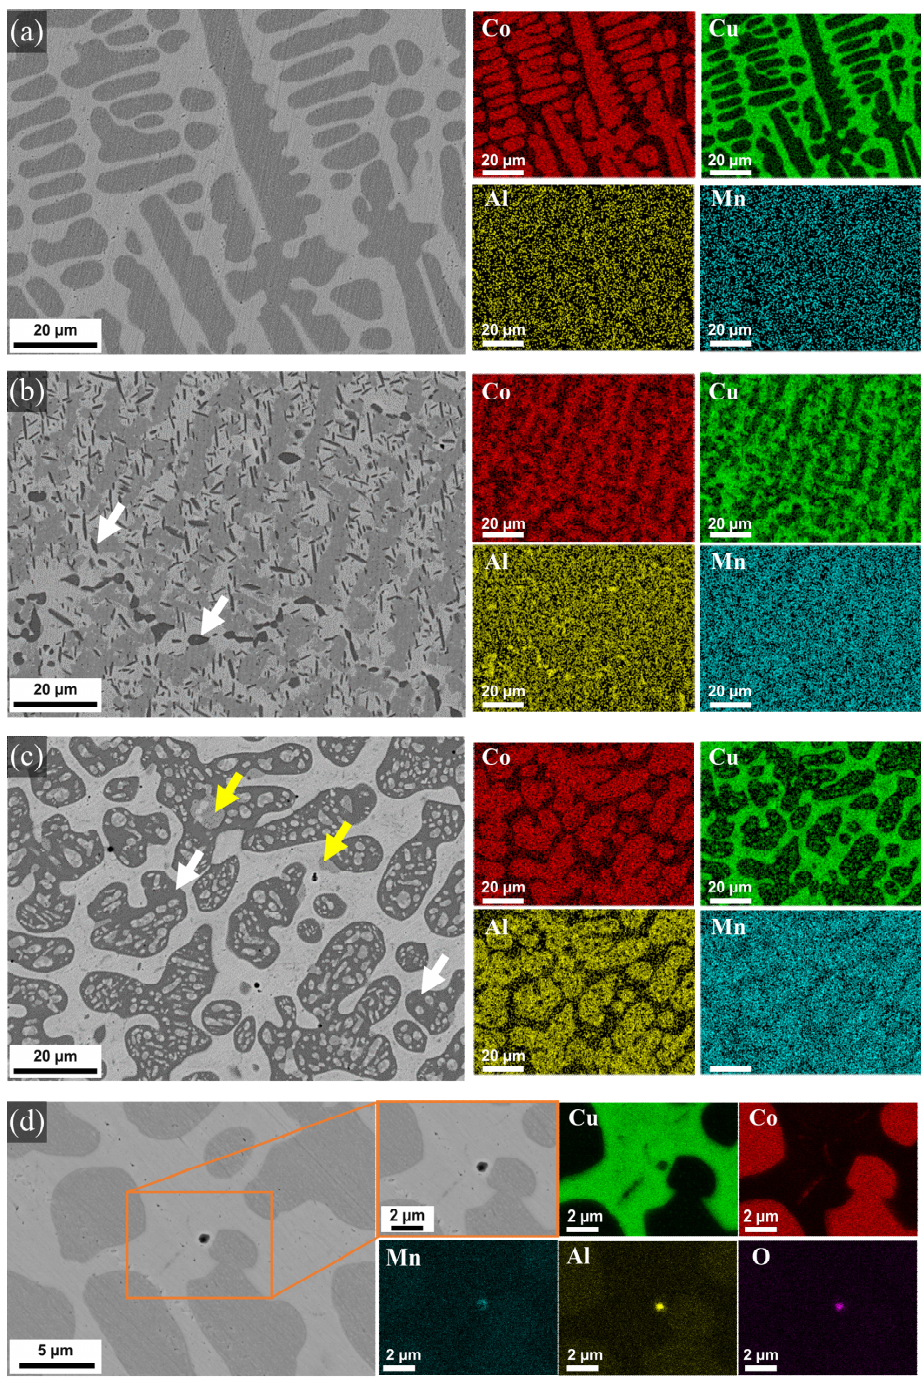
Figure 3. Back-scattered electron (BSE) images with energy dispersive spectroscopy (EDS) maps for Al, Co, Cu, and Mn of the ( a ) 2.5Al, ( b ) 10Al, and ( c ) 15Al alloys. The white and yellow arrows in ( b , c ) indicate B2 and Co-rich FCC, respectively. ( d ) High-magnification BSE images with EDS maps for Al, Co, Cu, Mn, and O in the 2.5Al alloys, indicating the AlMn-rich